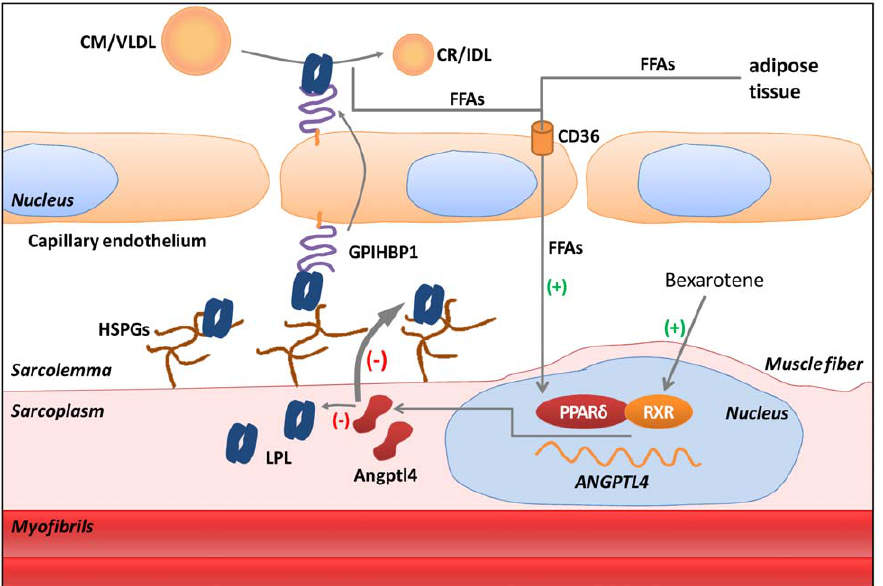
Figure 9. Proposed mechanism regulating LPL activity in the skeletal muscle. The working hypothesis is that FAs produced locally by LPL- mediated hydrolysis of VLDL and chylomicrons (CM) together with FAs derived from adipose tissue (FA-albumin) can activate PPAR d /RXR heterodimer which in turn upregulates Angptl4 gene expression. Angptl4 inhibits LPL activity mainly at the surface of the sarcolemma where less LPL will be available to be transported at luminal sites via the function of GPIHBP1. LPL inhibition by Angptl4 occurs to a lesser extent also intracellularly. This mechanism may protect the skeletal muscle from lipid overload and insulin resistance but may also contribute to bexarotene induced systemic hypertriglyceridemia.